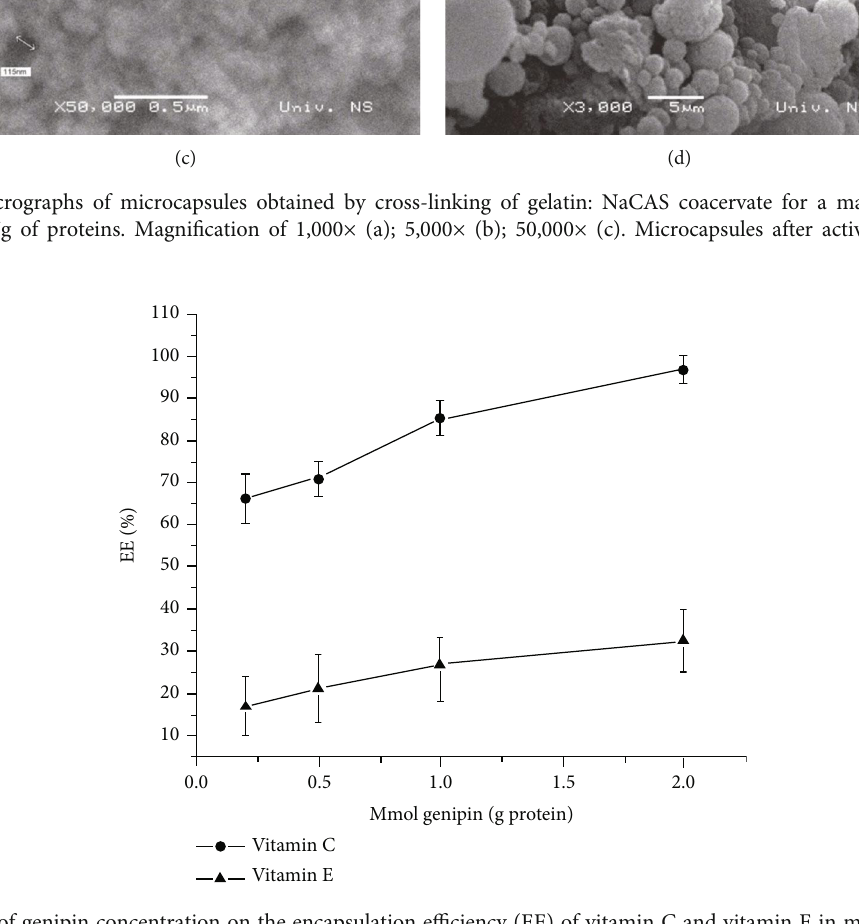
Figure 34: E ff ect of genipin concentration on the encapsulation e ffi ciency (EE) of vitamin C and vitamin E in microcapsules